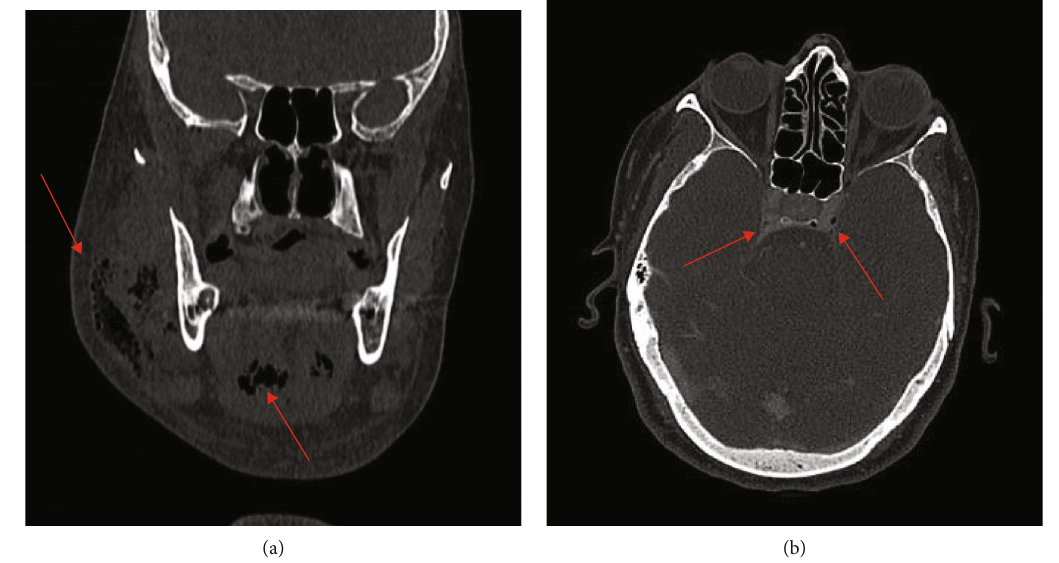
Figure 3: (a, b) Initial computed tomography (CT) of the head: frontal plane (a); transverse plane (b). Presence of gas bubbles in both cavernous sinuses, the right half of the face and buccal fl oor (red arrows)